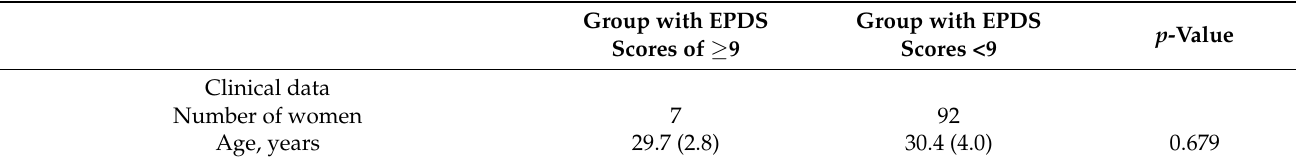
Table 3. Association between EPDS scores at 1 month postpartum and ketone